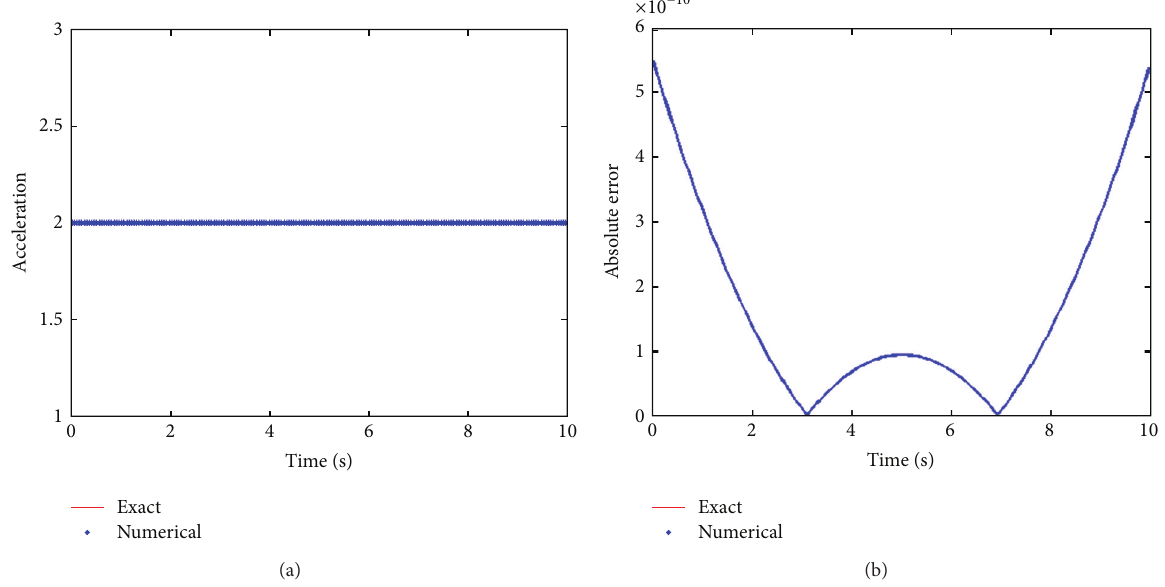
Figure 3: For Example 1, (a) comparing the exact solution and numerical one for acceleration and (b) displaying the estimated error of acceleration.